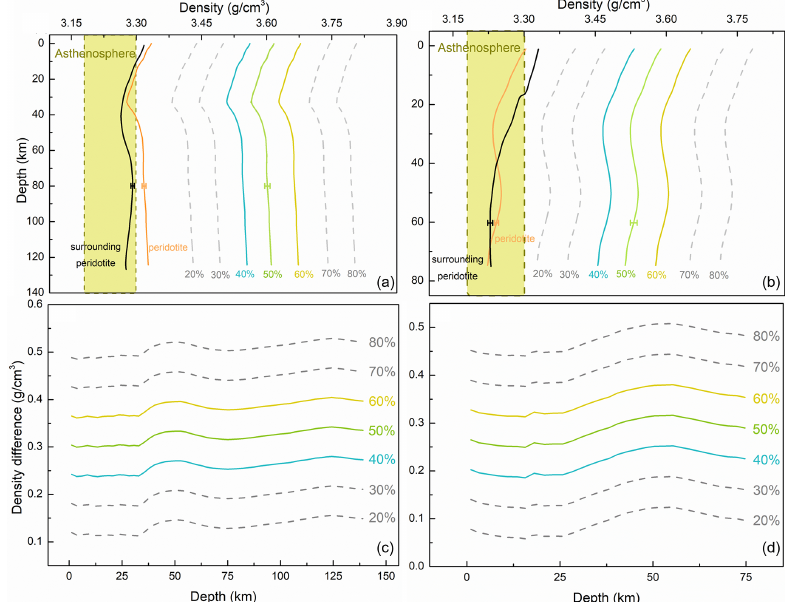
Figure 5. Density profiles of eclogite and peridotite assemblages (a and b) the density difference between eclogite and peridotite (c and d) in Tibet along the Paleozoic and Cenozoic geothermal lines under the conditions of Neo-Tethyan oceanic slab detachment (a) (Wang et al., 2013) as well as subduction of the Indian continental margin beneath the Lhasa terrane (b) (Craig et al., 2020). The percentage represents the content of garnet in eclogite, of which epidote accounts for 5vol% by default. The orange curve and black curves show the density profile of peridotite with a composition of 70vol% olivine + 25vol% orthopyroxene + 3vol% clinopyroxene + 2vol% spinel. The orange line shows the density of peridotite in the lithospheric mantle along the Paleozoic (a) (Wang et al., 2013) and Cenozoic (b) (Craig et al., 2020) geothermal lines, and the black curve indicates that the density of peridotite in the surrounding lithospheric mantle is along the Paleozoic (a) (Nábˇelek and Nábˇelek, 2014) and Cenozoic (b) (Wang et al., 2013) geothermal lines in Tibet. The shaded region is the density range of the asthenosphere (Chen and Tenzer, 2019; Levin, 2006; Panza et al., 2020; Singh and Mahatsente,